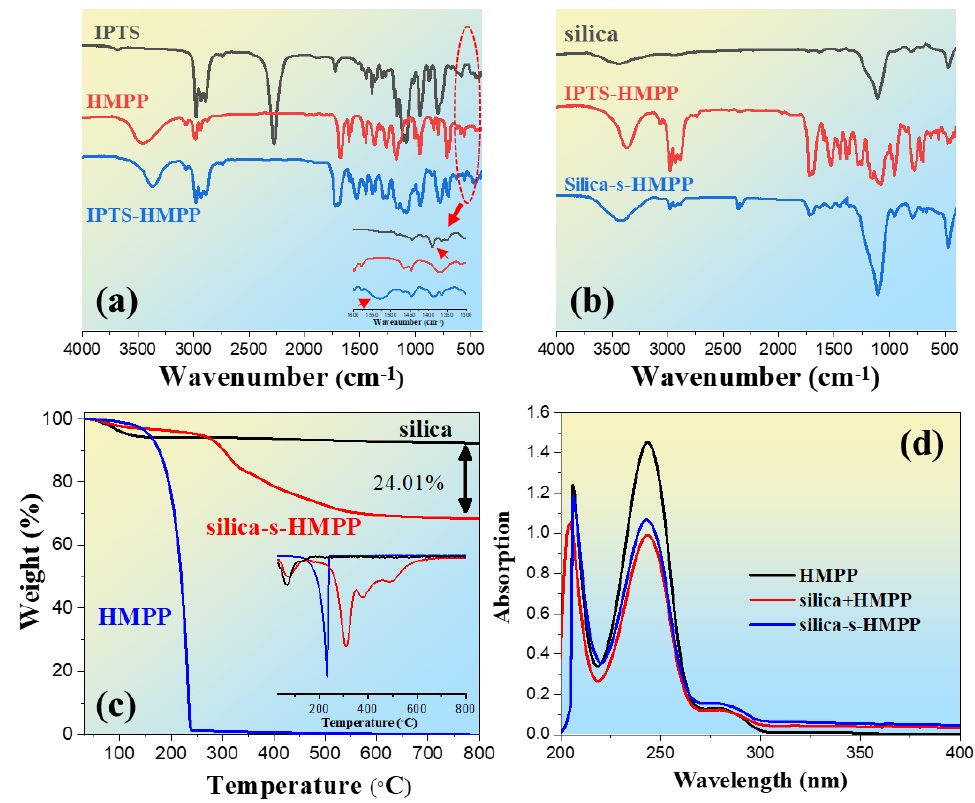
Figure 2. FTIR spectra ( a ) of IPTS, HMPP, and IPTS-HMPP and ( b ) of silica, IPTS-HMPP, and silica- s-HMPP; ( c ) TGA curves of silica, HMPP, and silica-s-HMPP (the insert curve is DTG curves), and ( d ) UV-vis absorption of HMPP, silica-s-HMPP, and the mixture of HMPP and silica